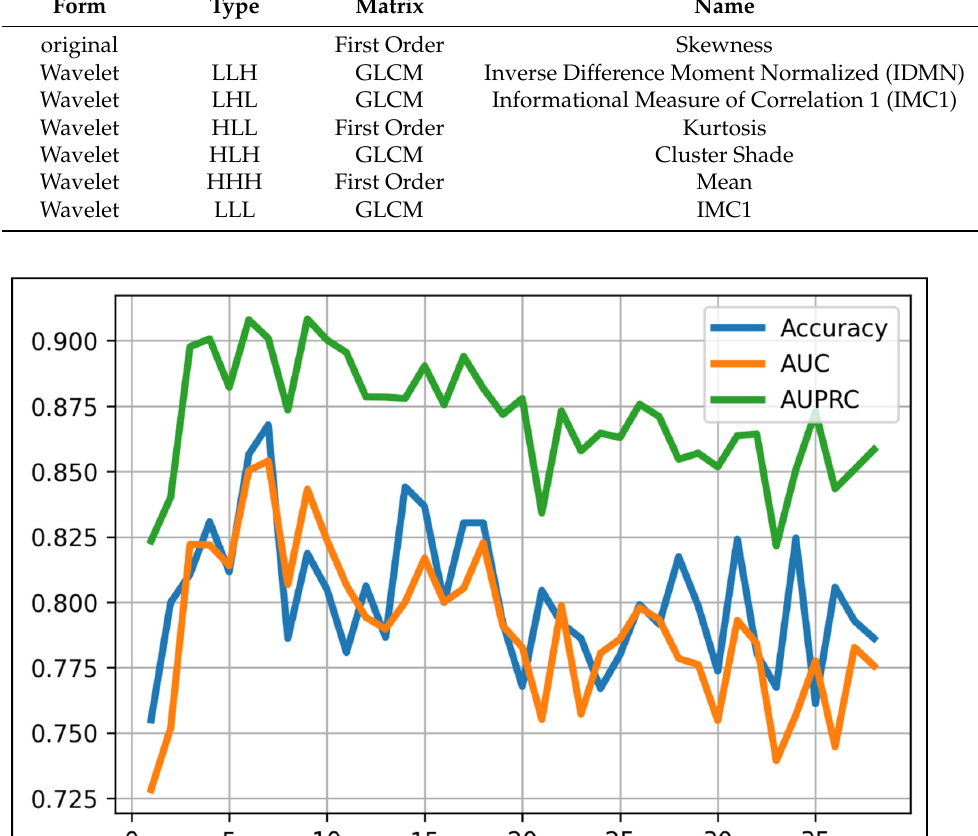
Table 2. Seven radiomics features using our final model.